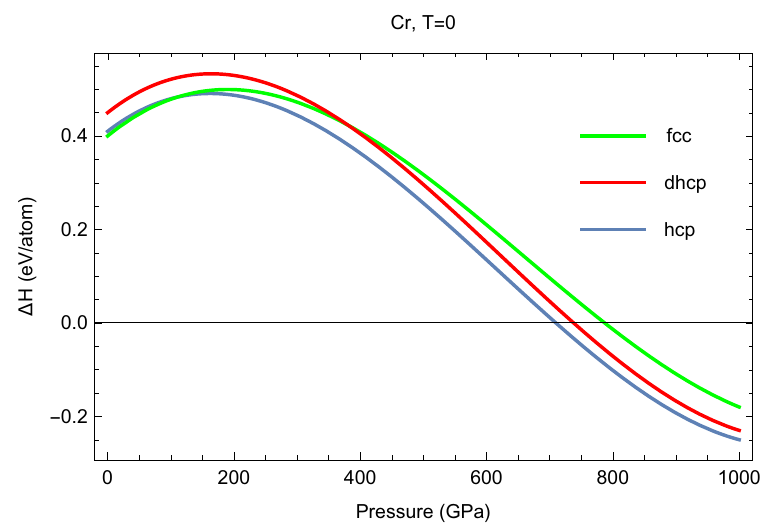
Figure 1. Cold enthalpies of three other solid structures of Cr as a function of P in relation to that of bcc-Cr assumed to be identically